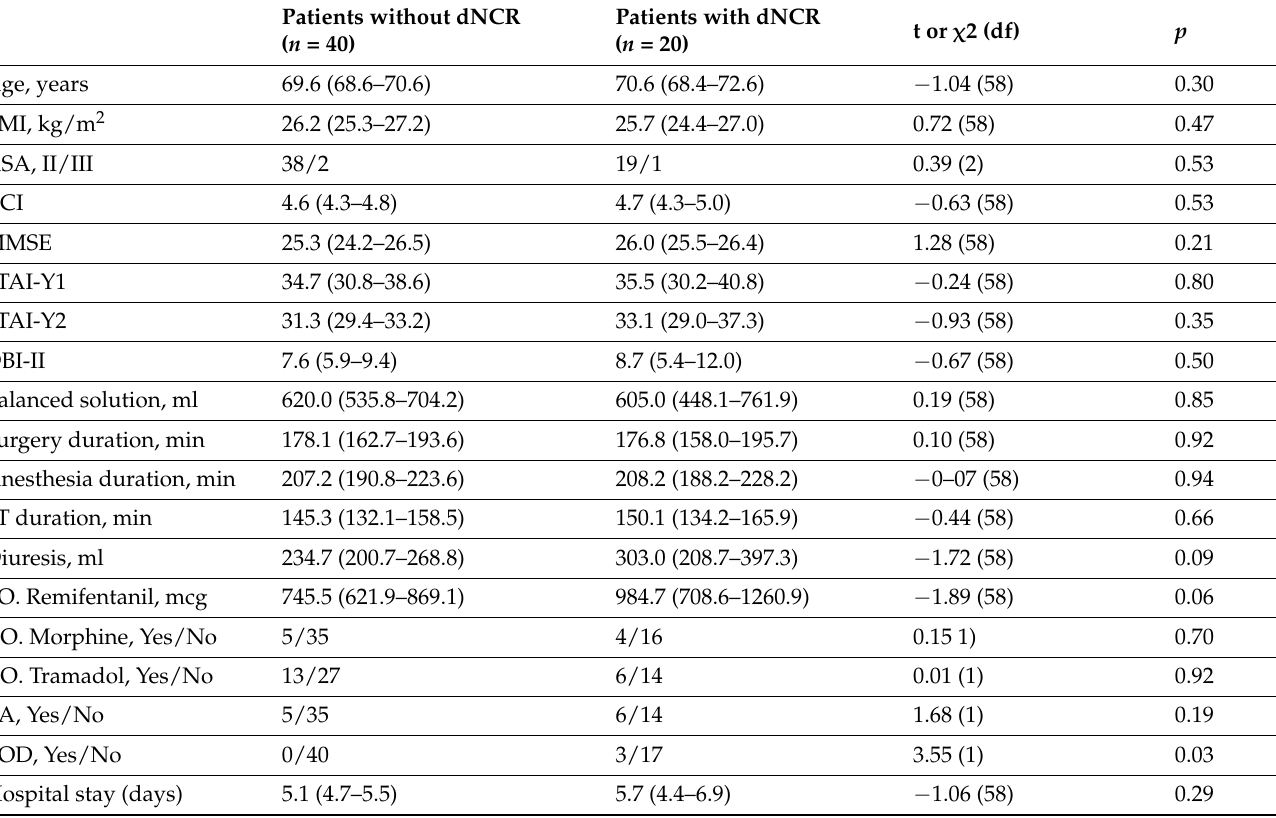
Table 1. Main pre-, intra-, and postoperative parameters in patients with and without dNCR. Values are means (95% confidence intervals) or numbers. BMI: Body Mass Index; ASA: American Society of Anesthesiologists physical status classification; CCI: Charlson Comorbidity Index; MMSE: